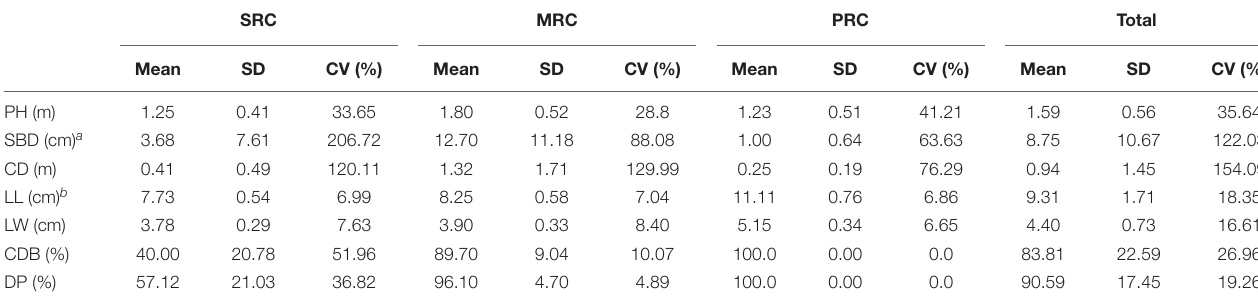
FIGURE 2 | Criteria for classifying individuals into strong, moderate, and poor resistance to cold. Images of three groups of plants were taken after the chilling event in the winter of 2015–2016. The red arrow points to the newly grown branches of the “dead” individual during the second survey. TABLE 2 | Phenotypic traits of three groups with different cold resistance in the YQ population after the chilling event during the winter of